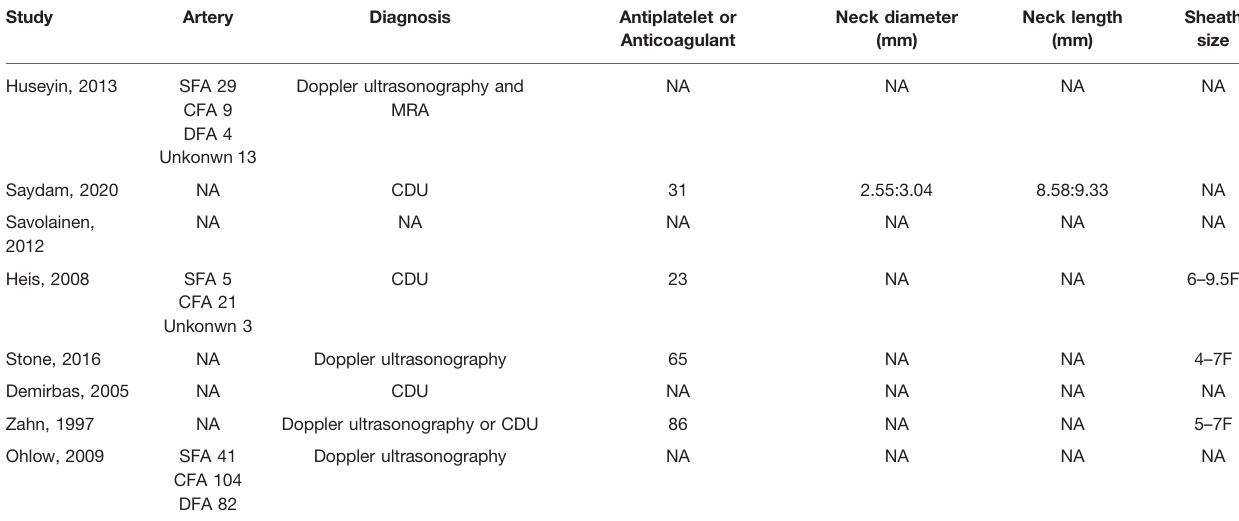
TABLE 2 | Supplementary characteristics of the studies.